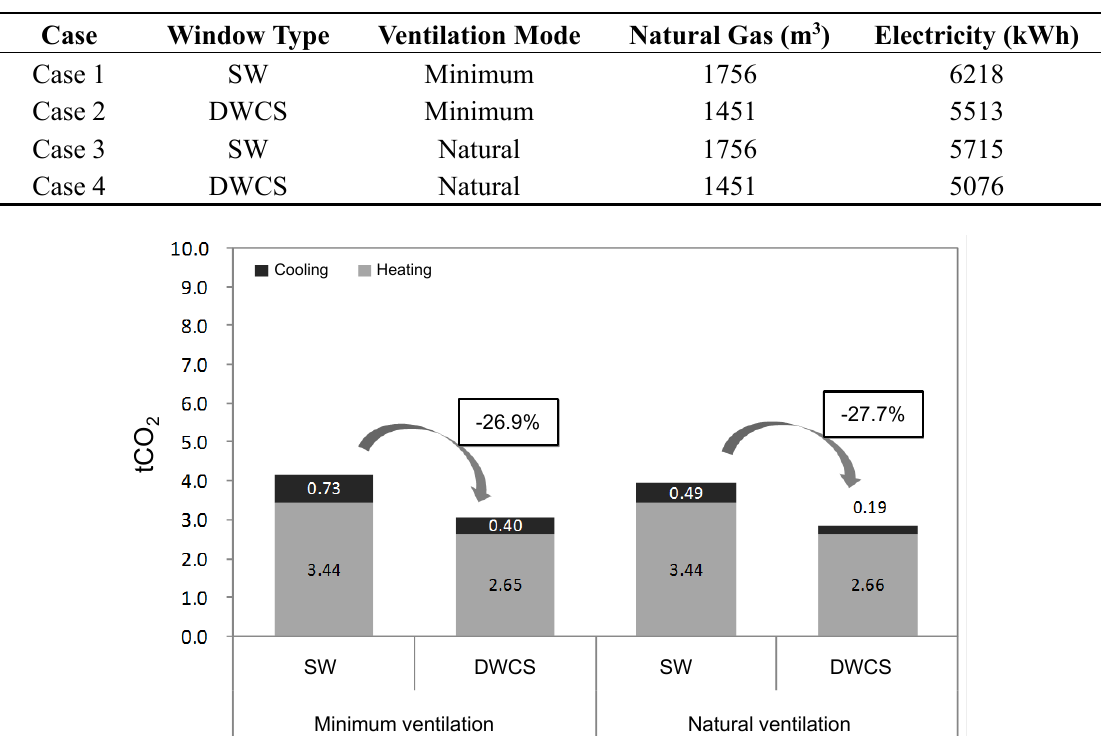
Table 10. Annual end-use energy consumption.